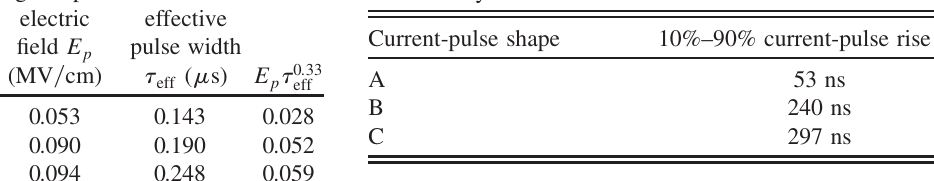
SHAPING THE OUTPUT PULSE OF A LINEAR- . . TABLE II. The rise time for three different current-pulse TABLE I. The highest peak voltage at the output of a cavity, shapes. For shape A, the switches of each cavity are closed at highest peak electric field E p , and associated effective pulse a time (cid:1) c later than the closure of the switches in the cavity width (cid:1) eff for each of current-pulse shapes A–F. The last column immediately upstream , where (cid:1) c is the time it takes an electro- lists values of the expression E p (cid:1) 0 : 33 eff assuming E p is given in MV = cm and (cid:1) (cid:2) s [54,55]. All the values of E (cid:1) 0 : 33 magnetic pulse to propagate (down the internal transmission eff in p eff are line) the length of a single cavity. For shape B, the switches in significantly below the design criterion of 0.108 proposed in all the cavities are closed simultaneously. For shape C, the Refs. [54,55]. switches of each cavity are closed at a time (cid:1) c later the cavity immediately downstream .